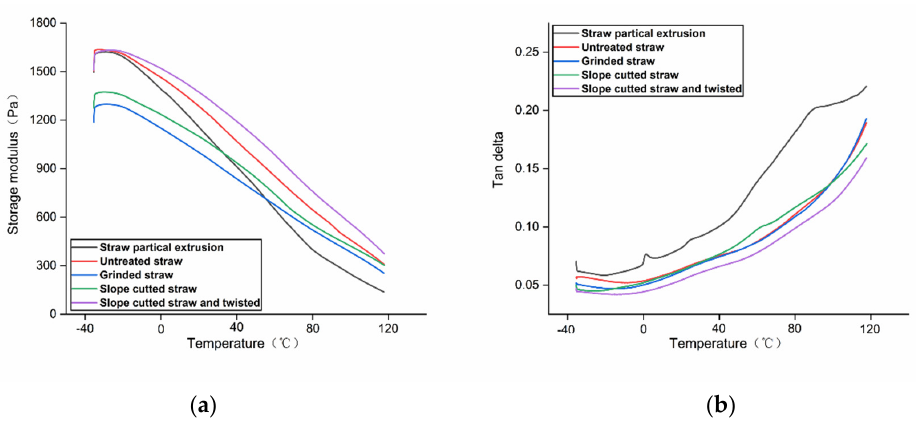
Figure 9. DMA thermogram of straw/LLDPE composites. ( a )Storage modulus; ( b )Tan data When the slope-cut and twisted long straw composite was loaded, the energy loss caused by viscous deformation was relatively small. During the stress deformation pro- cess, the good interfacial bonding and compact structure inhibit the relative sliding of LLDPE molecular chains, enhancing the mechanical internal friction of the composite. While the particles of the straw composite showed higher viscous deformation and better flexibility, the combination of slope-cutting and twisting made the composite less viscous and more rigid, so it had the lowest loss factor (Figure 9b).